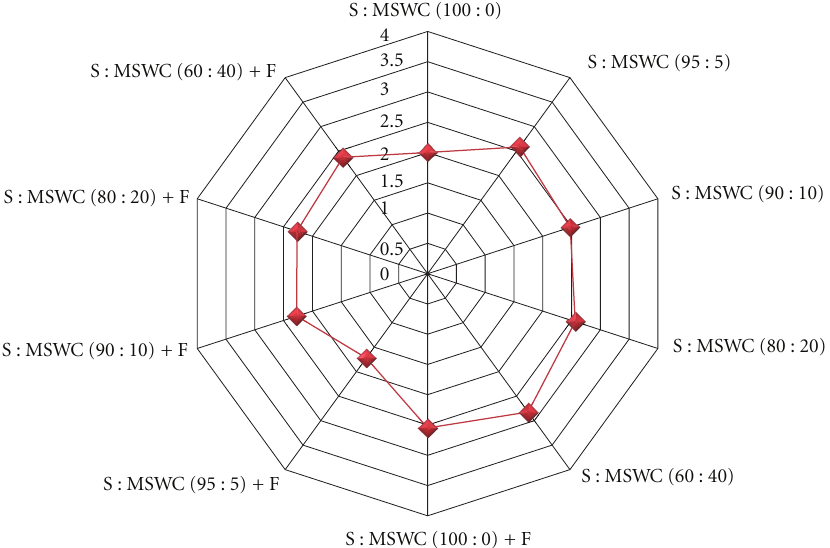
Figure 7: E ff ects of municipal solid waste compost (MSWC) into soil (S) without or with fertigation (F) on fruit marketability in 1–4 scale (1: extra quality; 2: good quality; 3: medium quality; 4: not marketable quality) of greenhouse pepper crop. Values represent mean of measurements made on average 23 fruits per